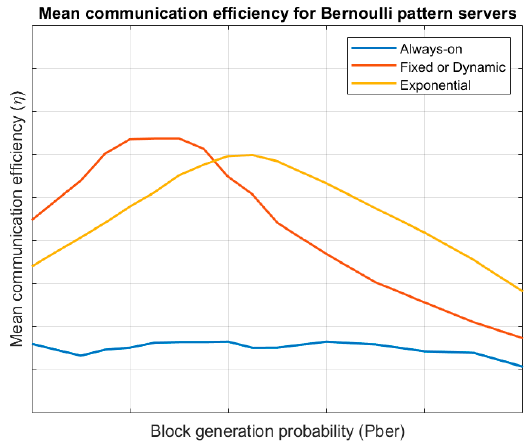
Figure 4. Mean communication efficiency for Bernoulli pattern servers.